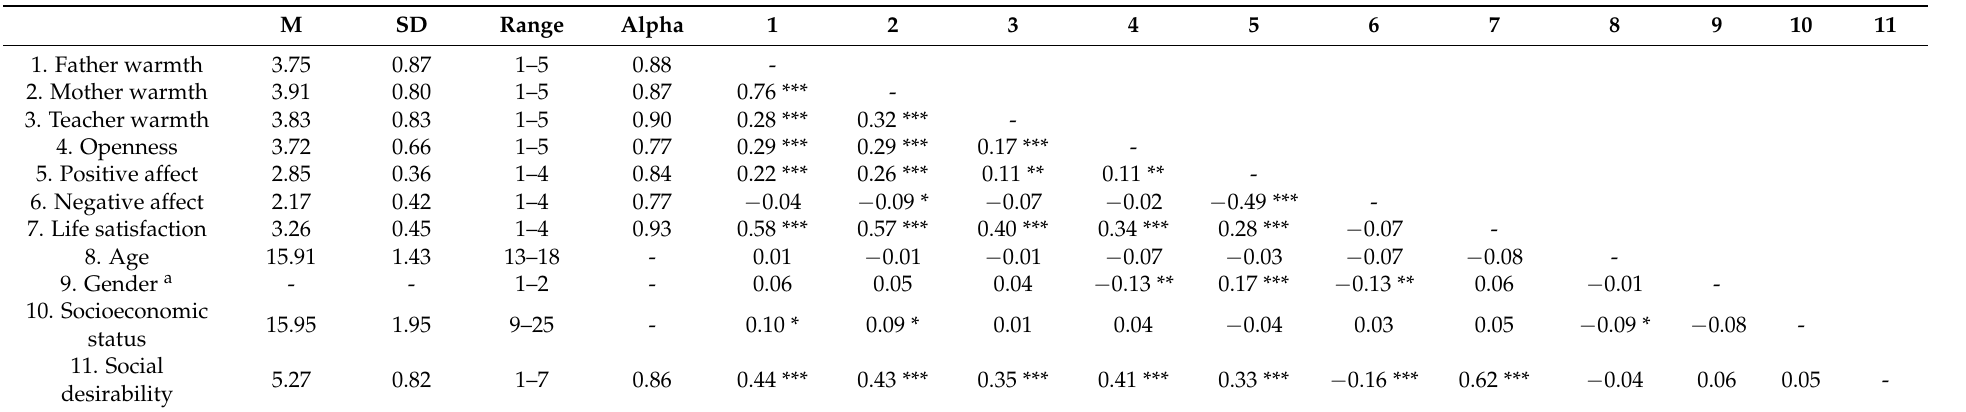
Table 2. Descriptive statistics and intercorrelations among variables for non-left-behind